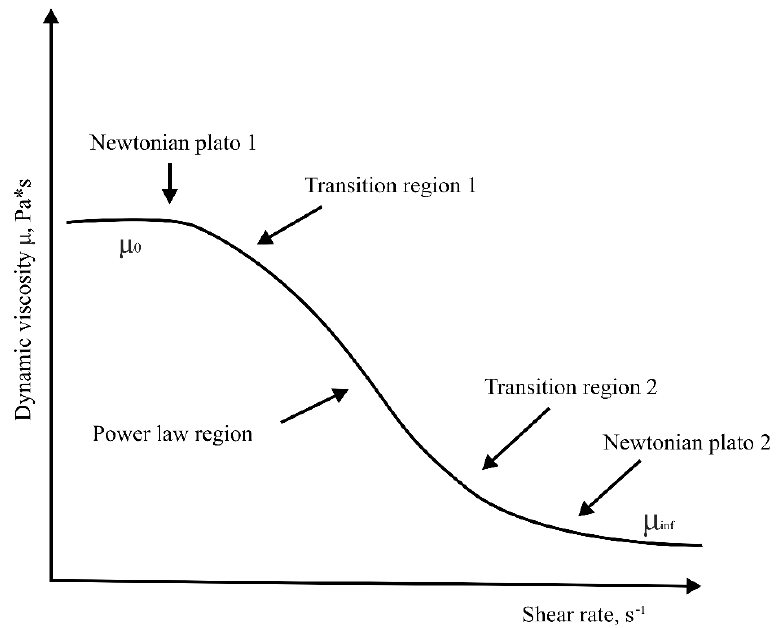
Figure 1. General graphical representation of the Carreau model in the axes «dynamic viscosity coefficient–shear rate».